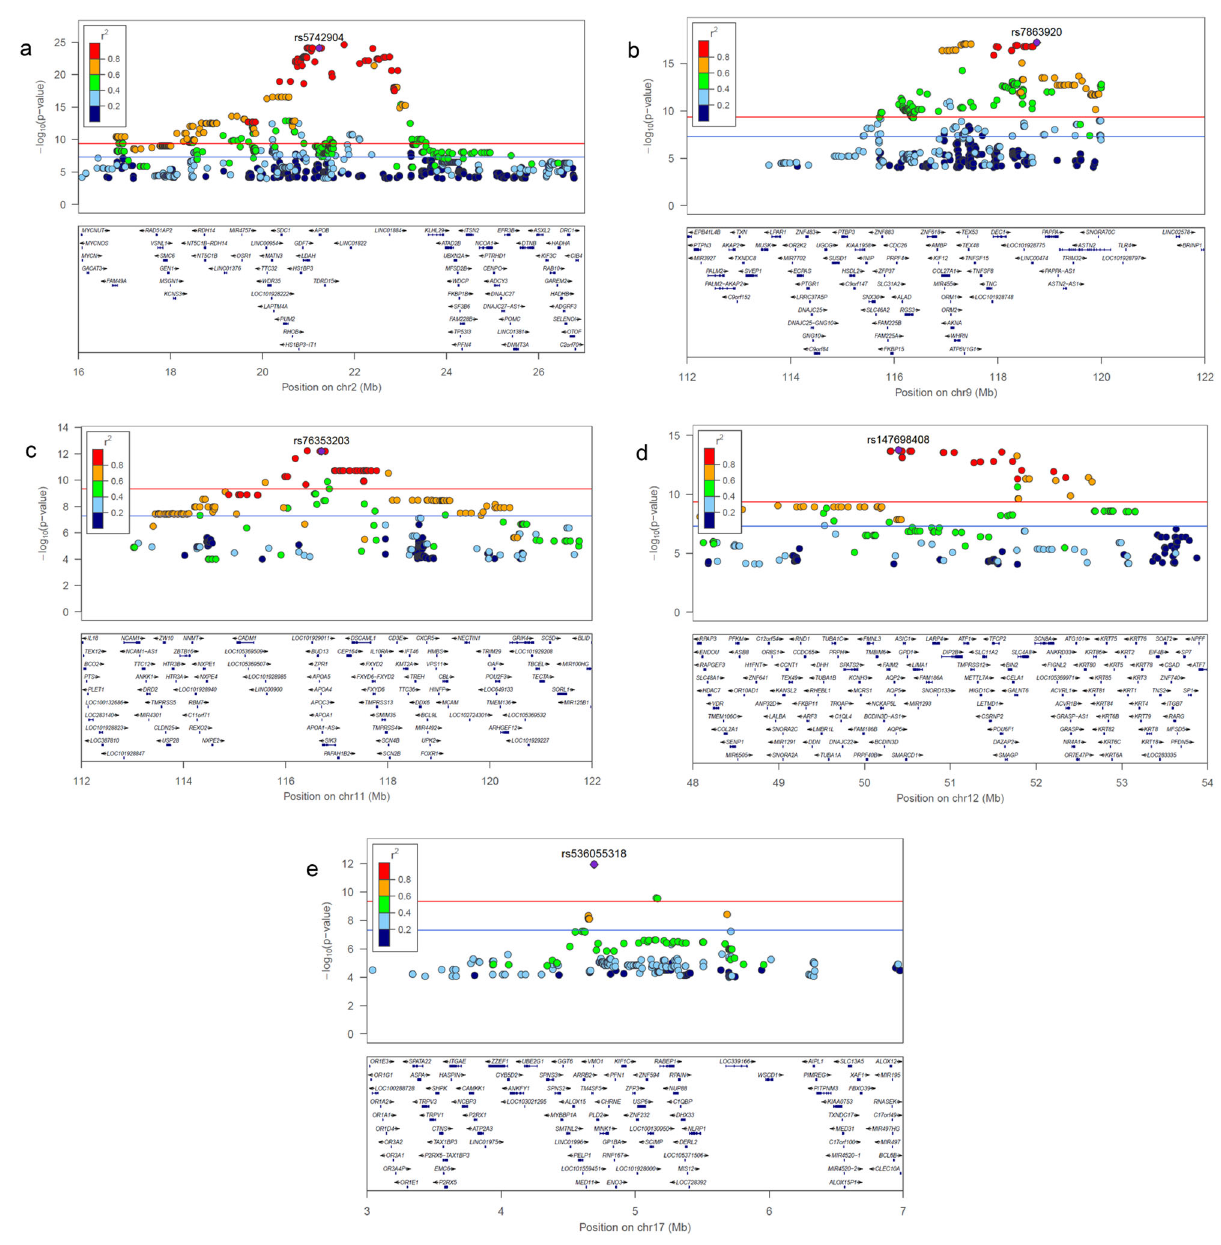
Fig. 4 Rare-population but Amish-enriched loci. Locus zoom for 5 loci in a , chromosome 2 with SM(d34:1) b , chromosome 9 with GlcCer(d42:2) c , chromosome 11 with PE(36:2) d , chromosome 12 with SM(d32:2) and e , chromosome 17 with SM(d40:0). All p-values based on t -test using additive genetic model. GlcCer Glycosphingolipids, PE Phosphatidylethanolamine, SM